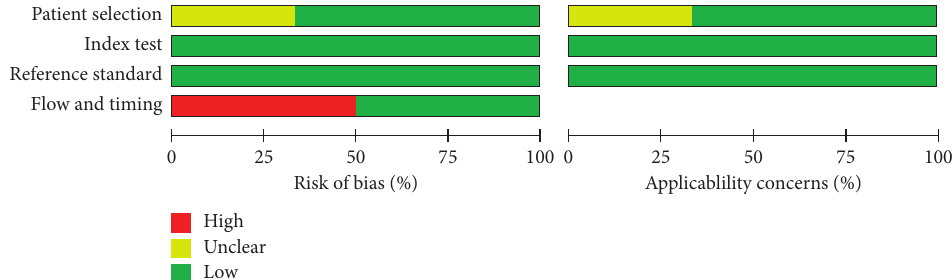
Figure 1: Methodological evaluation of the included studies according to QUADAS-2. Graphical display of the QUADAS-2 results showing the proportion of studies with high, low, or unclear risk levels of bias. QUADAS-2 � Quality Assessment of Diagnostic Accuracy Studies-2.